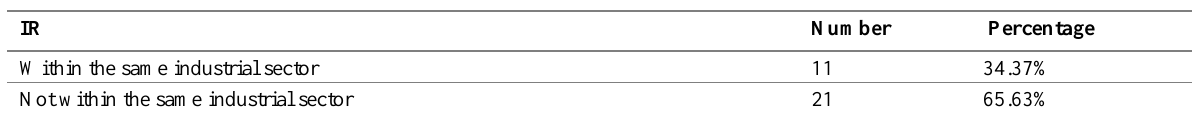
Table 3: Industry Relatedness